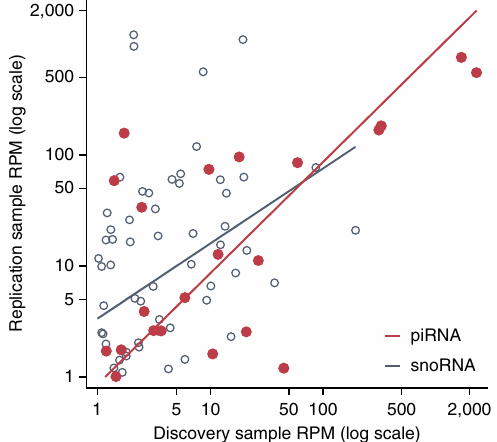
Figure 2 | Overlapping expression of piRNAs and snoRNAs between post-MI and FHS Cohorts. Using the same detection threshold as in our discovery phase (average RPM Z 1K combined), the replication sample detected 111 piRNAs and 164 snoRNAs with statistically significant correlation between the RPM values for snoRNAs (Spearmans r ¼ 0.32, P ¼ 0.02) and piRNAs (Spearman’s r ¼ 0.53, P ¼ 0.01) between the FHS and BIDMC cohorts.